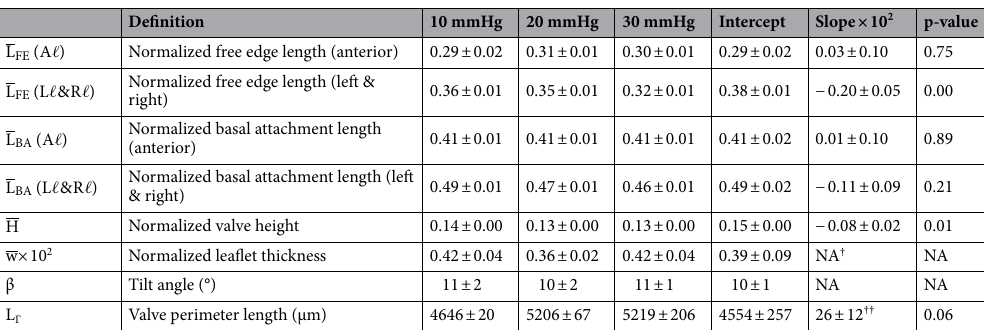
Table 1. Definition and statistical analysis results for the gQOIs. The dimensional gQOIs (row 2–7) are normalized with respect to the valve perimeter length L Γ (row 9), hence unitless. Column 3–5: mean ± s.e.m of the gQOIs at different TVPs. Column 6–8: mean ± s.e.m of the intercept and slope of the linear/constant regression model that fits all data at 10, 20, and 30 mmHg. The unit of the slope is mmHg −1 for row 2–6 and µm × mmHg −1 for row 9, respectively. For applicable gQOIs, the p-values were generated from the t-statistic of the hypothesis test that the slope of the linear regression model is equal to zero or not. Here, A ℓ , L ℓ , R ℓ indicate the anterior, left, and right leaflets, respectively. † NA indicates that constant regression model is used. †† Actual value is reported without multiplying 10 2 as in row